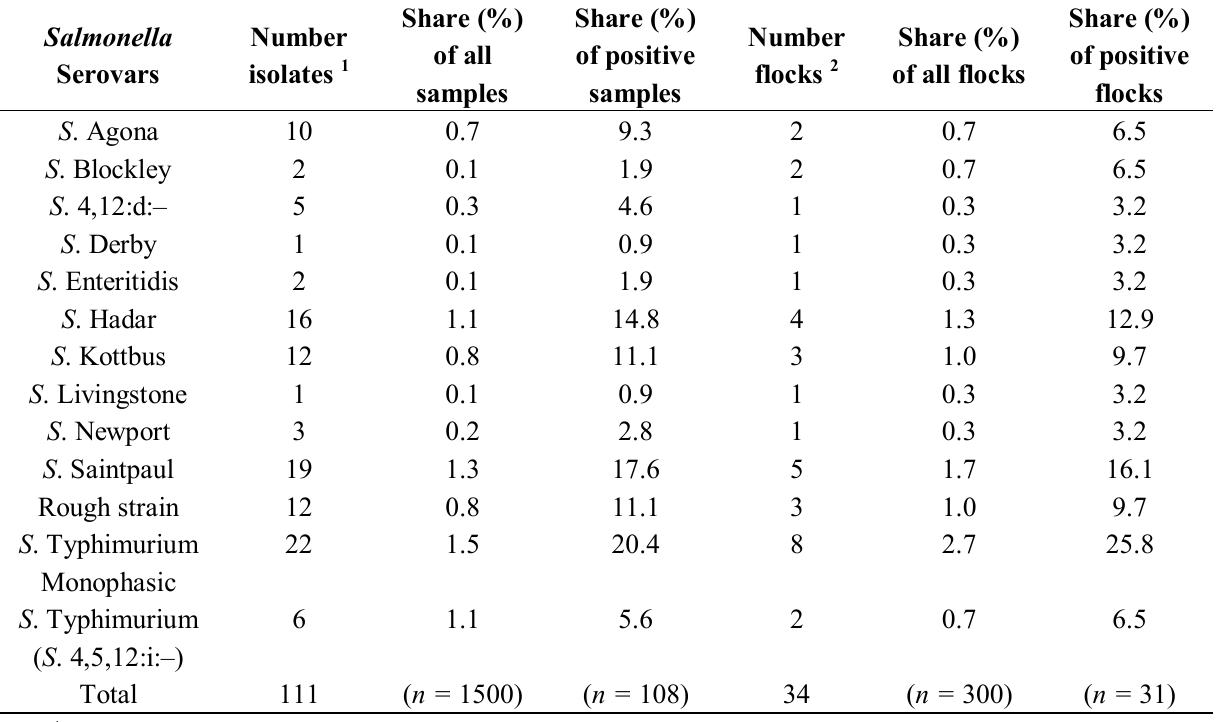
Table 4. Salmonella serovars in fattening turkeys during the baseline